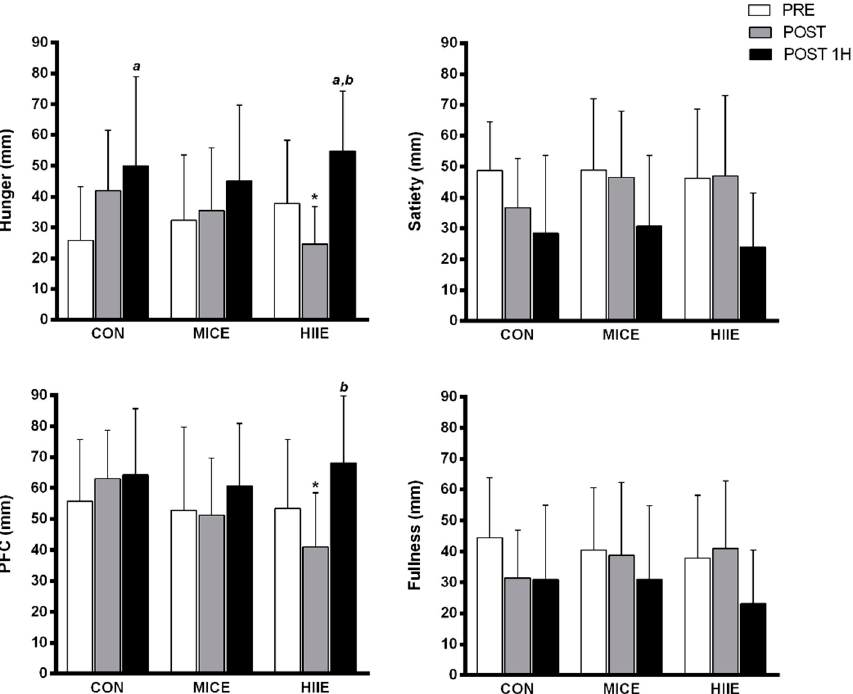
Figure 4. Subjective appetite perception at different exercise conditions and control. Values presented in mean ± SD. a Significantly different from PRE ( p < 0.05); b Significantly different from POST; * Significantly different from CON at same time point ( p < 0.05).